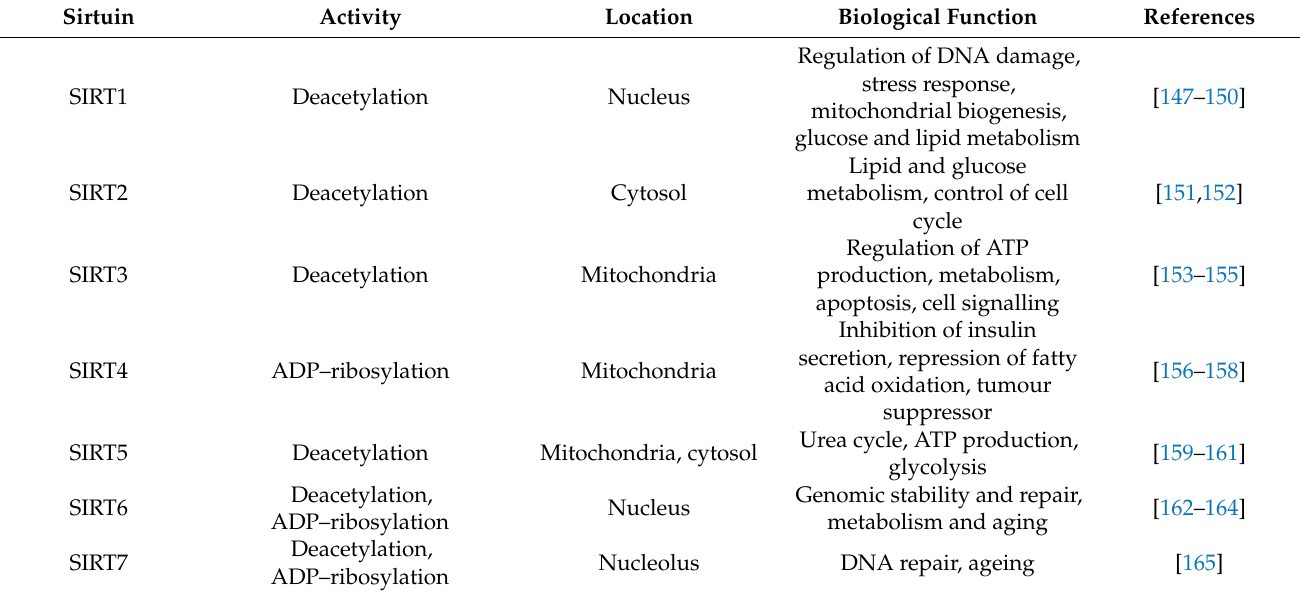
Table 3. Localisation and activity of sirtuins in